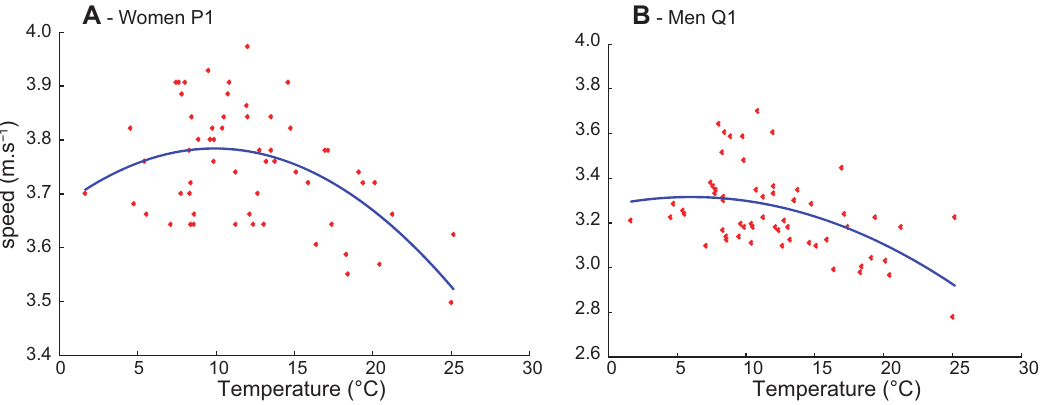
Figure 3. Quadratic second degree polynomial fit for Women’s P1 running speeds vs. air temperature, r 2 =0.27; p , 0.001; max=9.9 6 C. B) Men’s Q1 running speeds vs. air temperature, r 2 =0.24; p , 0.001; max=6 6 C.